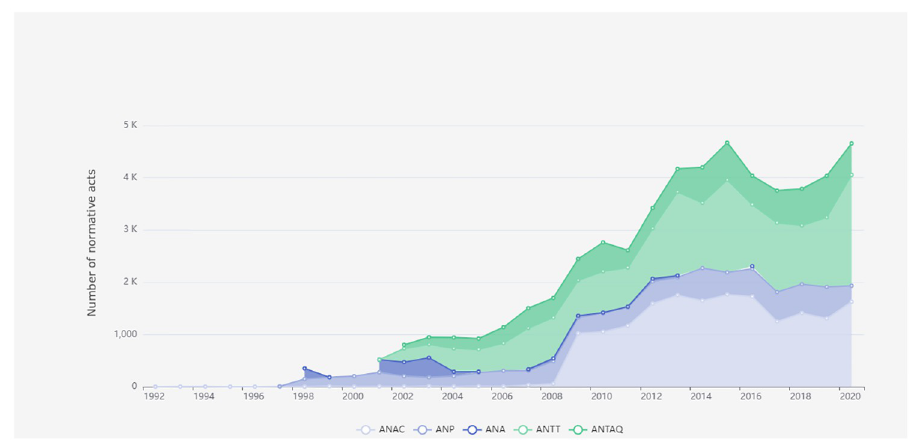
Fig 3. Normative acts of regulatory agencies over time.